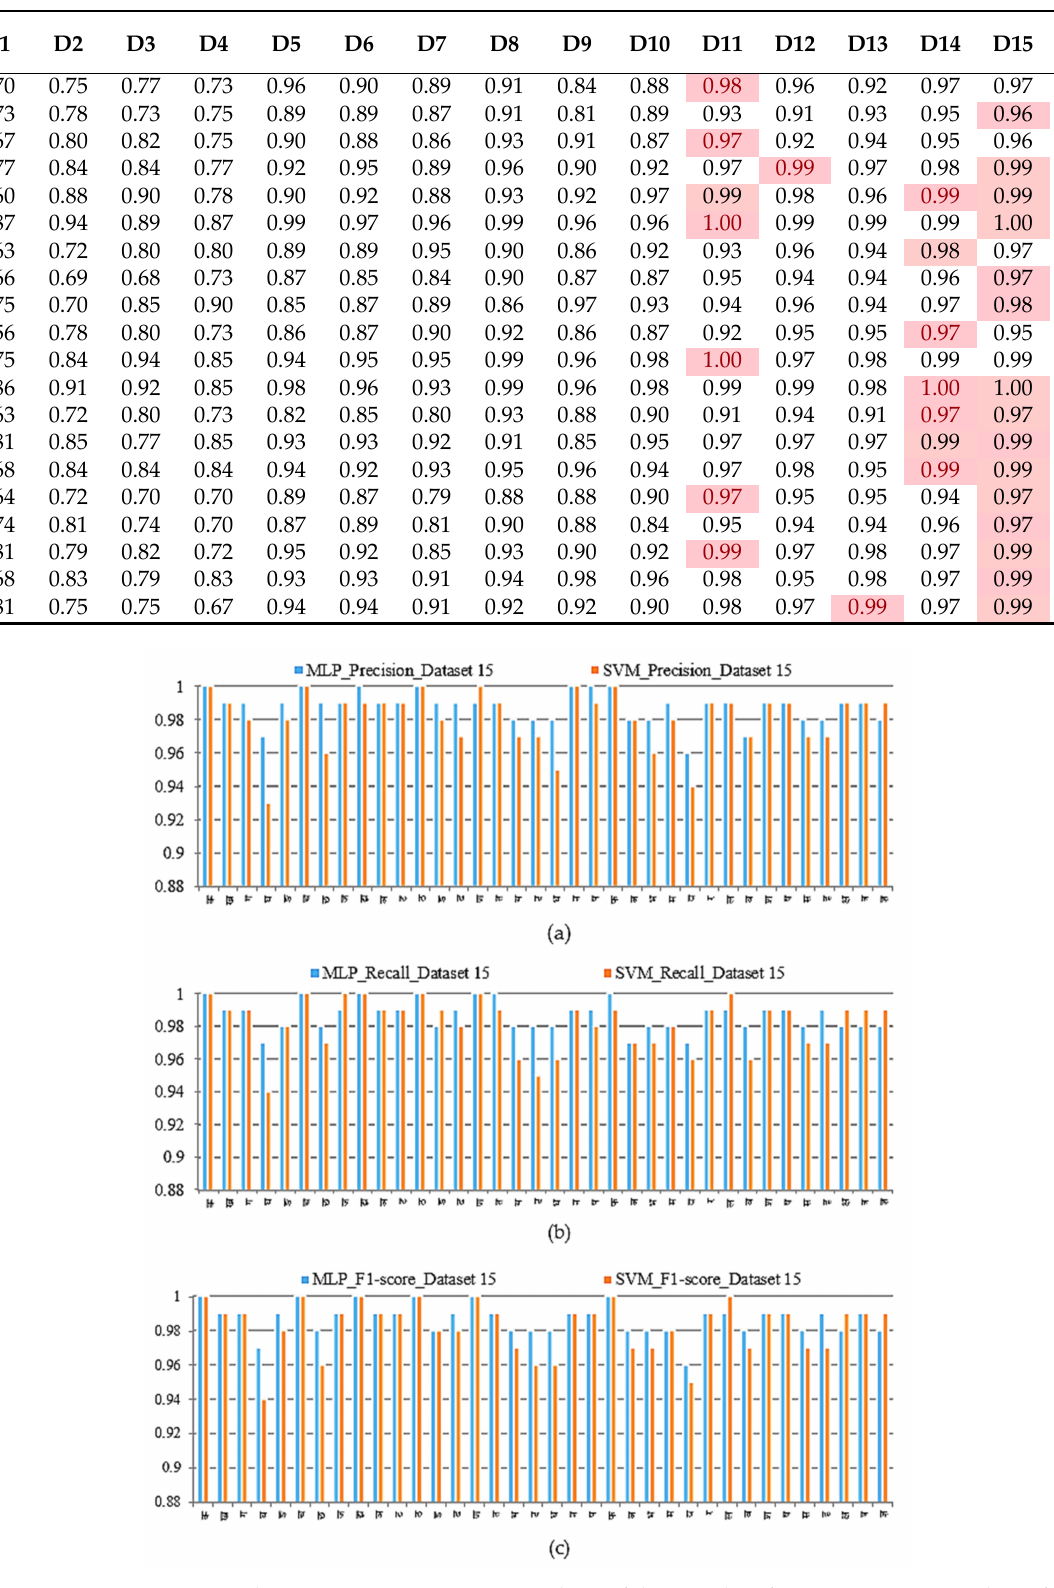
Figure 8. Character‑wise comparative analysis of the two classifiers: ( a ) precision analysis ( b ) recall analysis and ( c ) F1‑score